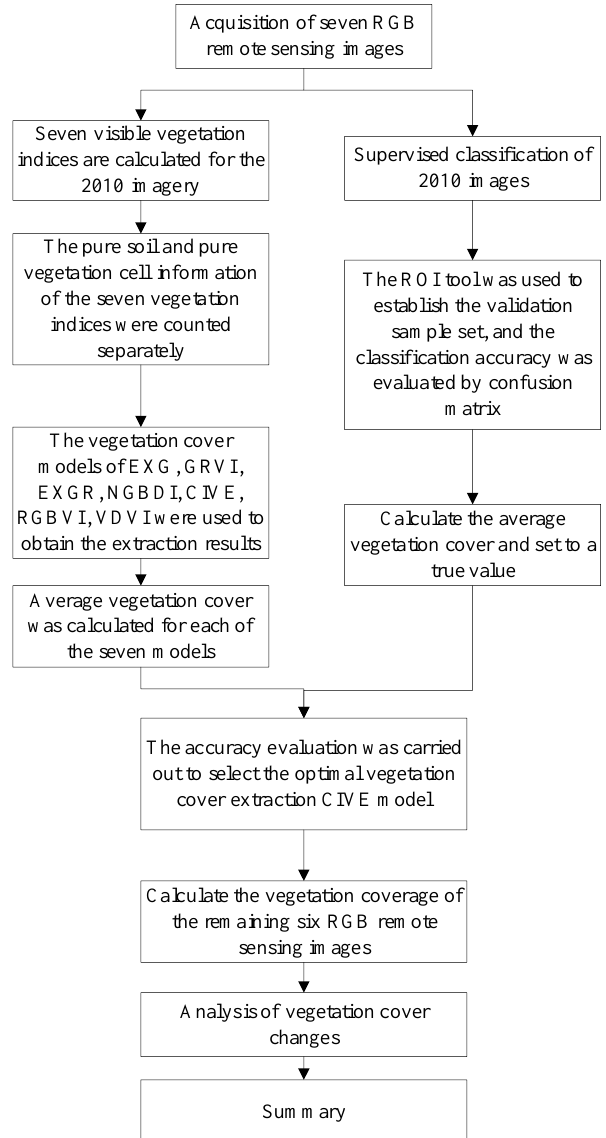
Figure 3. Vegetation coverage change analysis